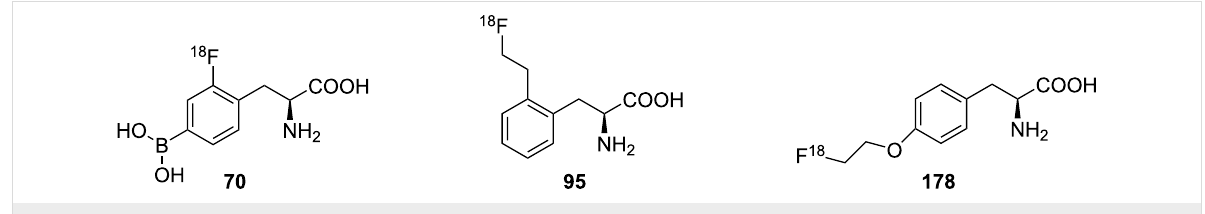
Figure 2: Structures of PET radiotracers of 18 FPhe derivatives.